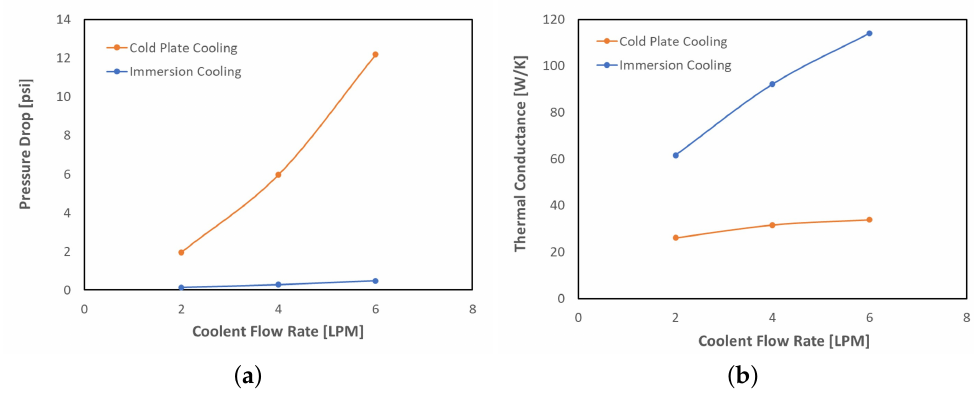
Figure 12. Effect of variation of flow rate on ( a ) coolant pressure drop (psi), and ( b ) average thermal conductance (W/K).